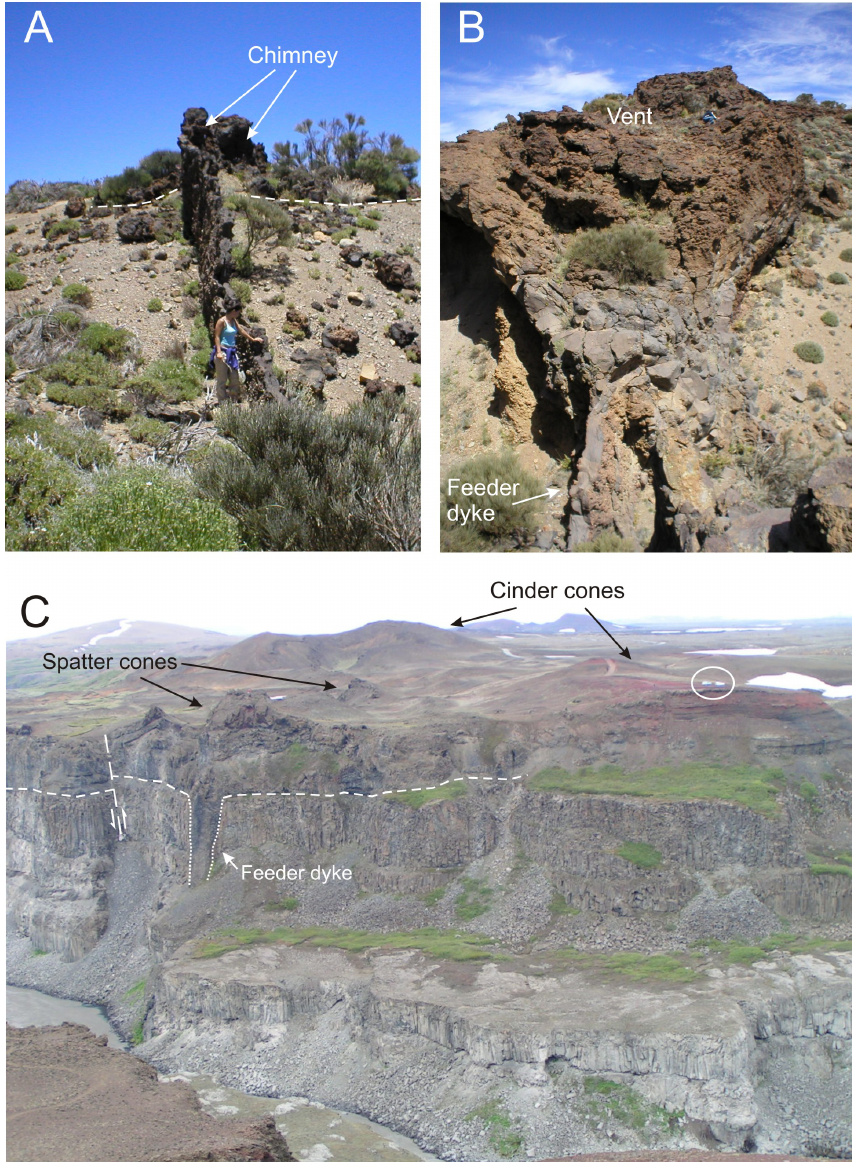
Fig. 3. Examples of subvertical sheet-like feeder dykes: (A) the Colmenas feeder dyke (Tenerife) connected to chimneys; (B) the Colmenas feeder dyke connected to a spatter cone; and (C) the Raudholar feeder dyke (Iceland) connected to a spatter cone. Observe the normal fault reactivated as a reverse fault by the dyke intrusion (Gudmundsson et al., 2008). See text for explanation. Dash lines indicate the palaeo-surface prior to the eruption. See persons for scale in (A) and (B) ; and cars inside the white circle for